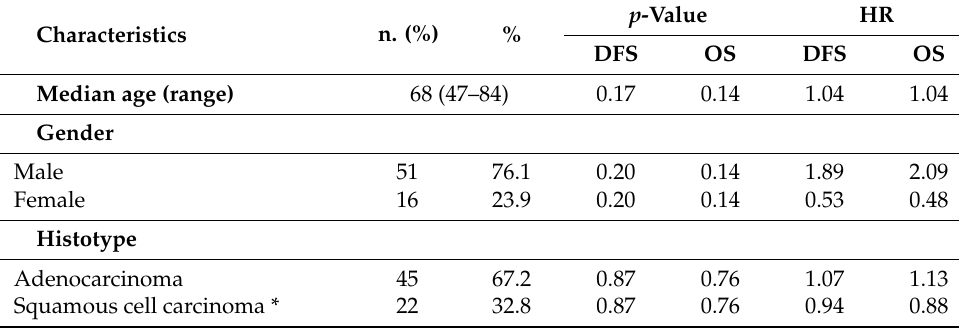
Figure 1. Flow chart of patient selection based on eligibility criteria. * One patient had adeno- squamous histology. Abbreviation: DR: disease recurrence; mDFS: median disease-free survival in months; mOS: median overall survival in months. Table 1. Clinical and pathological characteristics of the 67 eligible